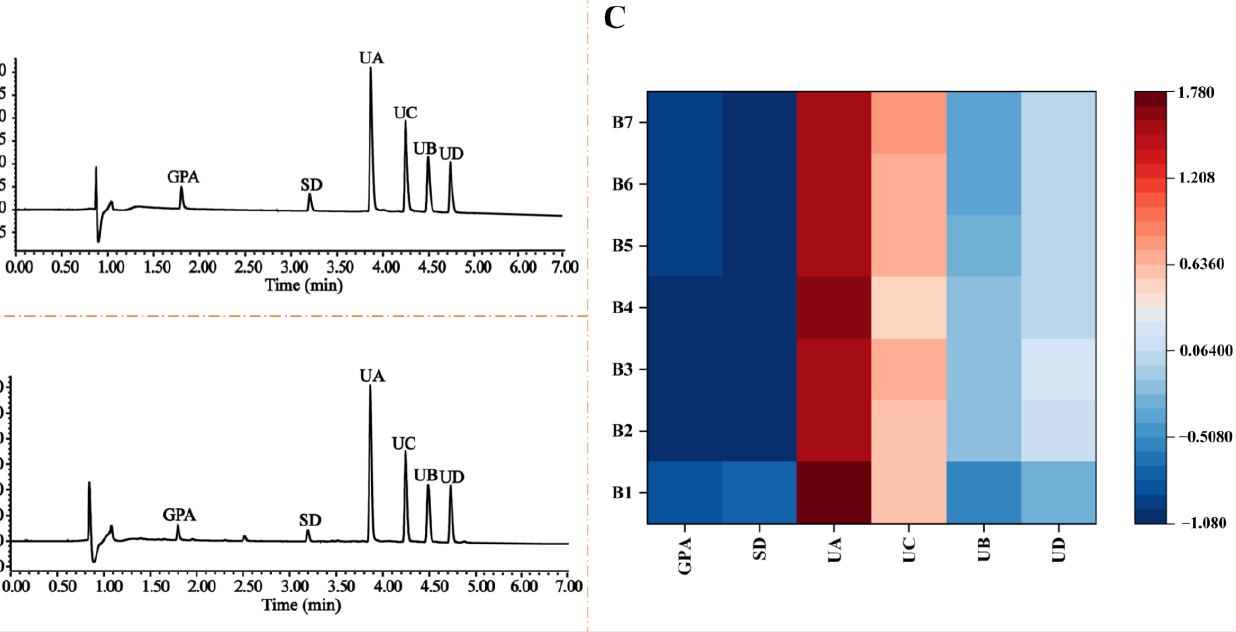
Figure 3. The representative UPLC chromatograms of the mixed reference compounds ( A ), and the sample solution of seed meal of E. ulmoides Oliv. ( B ); The heatmap of relative contents of the tested compounds in seed meal of E. ulmoides Oliv. from different origins ( C ). Table 1. Summary results of linear regression, LODs, LOQs, precision, repeatability, stability, and recovery for six tested compounds in seed meal of E. ulmoides Oliv.